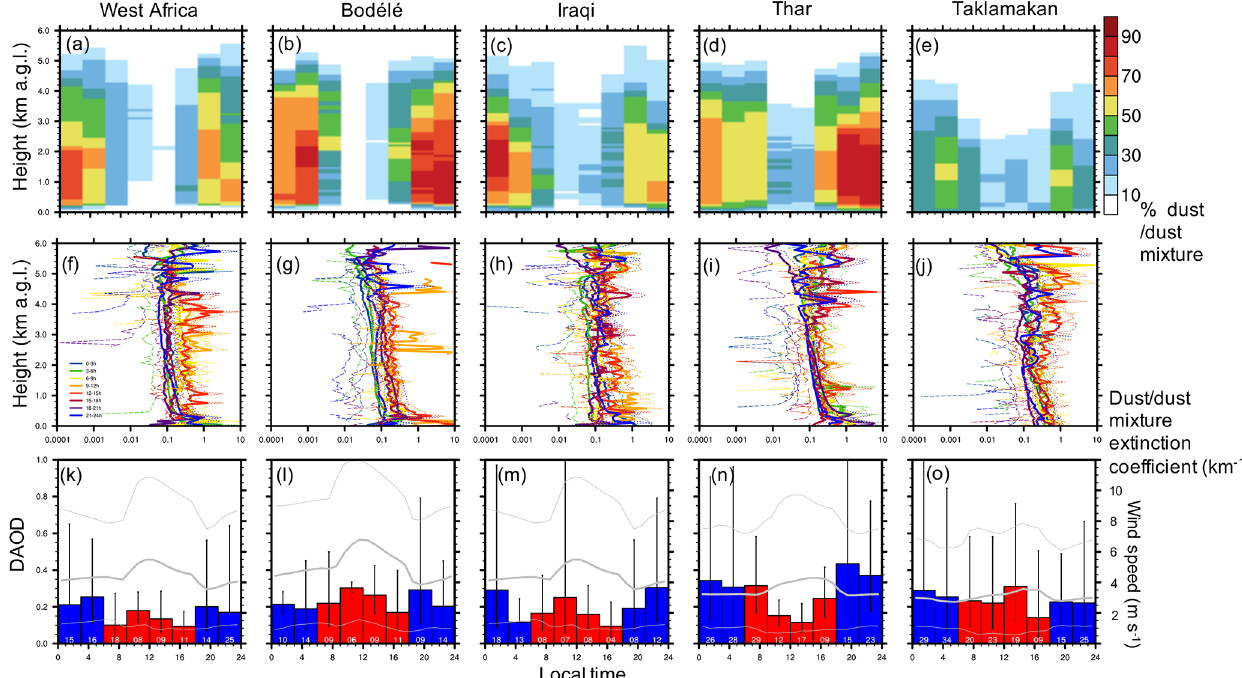
Figure 10. Diurnal cycle of dust and dust mixture characteristics observed by CATS over five key dust source regions during boreal winter (December–February, DJF). (a–e) Regional average percentage of observations when dust or dust mixture is identified as the dominant aerosol feature by height. (f–j) Mean (solid lines) and variation (10th and 90th percentiles among all pixel-level observations, dashed lines) in dust and dust mixture extinction by height. (k–o) Regional mean DAOD (average across multiple overpasses: bars, with red and blue bars representing daytime and nighttime observations, respectively; minimum and maximum across multiple overpasses: vertical lines) referring to the left y axis, and regional mean 10m wind speed (ms − 1 , grey lines) referring to the right y axis. The hourly wind speed data were obtained from the WATCH Forcing Data for ERA5 (Beck et al., 2017; Cucchi et al., 2020). The thick and thin lines represent the average, minimum, and maximum wind speed during DJF in 2015–2017. In panels (f–j) , a line break associated with the 10th percentile indicates that more than 10% of the pixel-level dust and dust mixture extinction coefficient equals 0. Number of CATS overpasses per region per time window is indicated in panels (k–o) . The location of each dust source region is indicated in Figs. 4 and